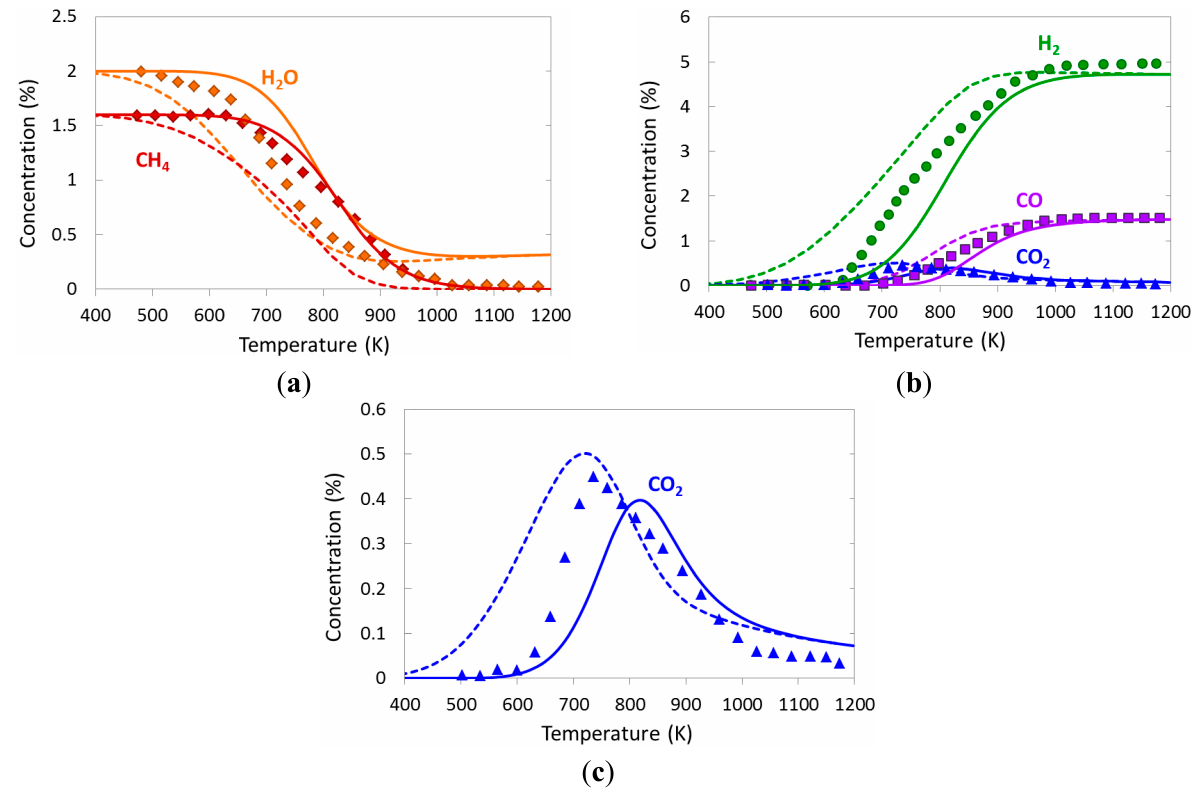
Figure 7. Comparison of experimentally determined (symbols) and numerically predicted (lines) concentrations as a function of temperature for catalytic steam reforming of methane: ( a ) reactants; ( b ) products; ( c ) zoom-in of CO 2 formation; C/S = 0.8 in N 2 , 1 bar; T inlet = 373 K; total flow rate of 4 slpm, dashed lines = equilibrium composition at given